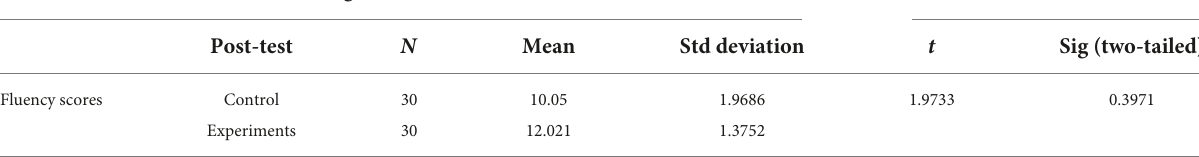
TABLE 2 Post-test scores of controls and experimental